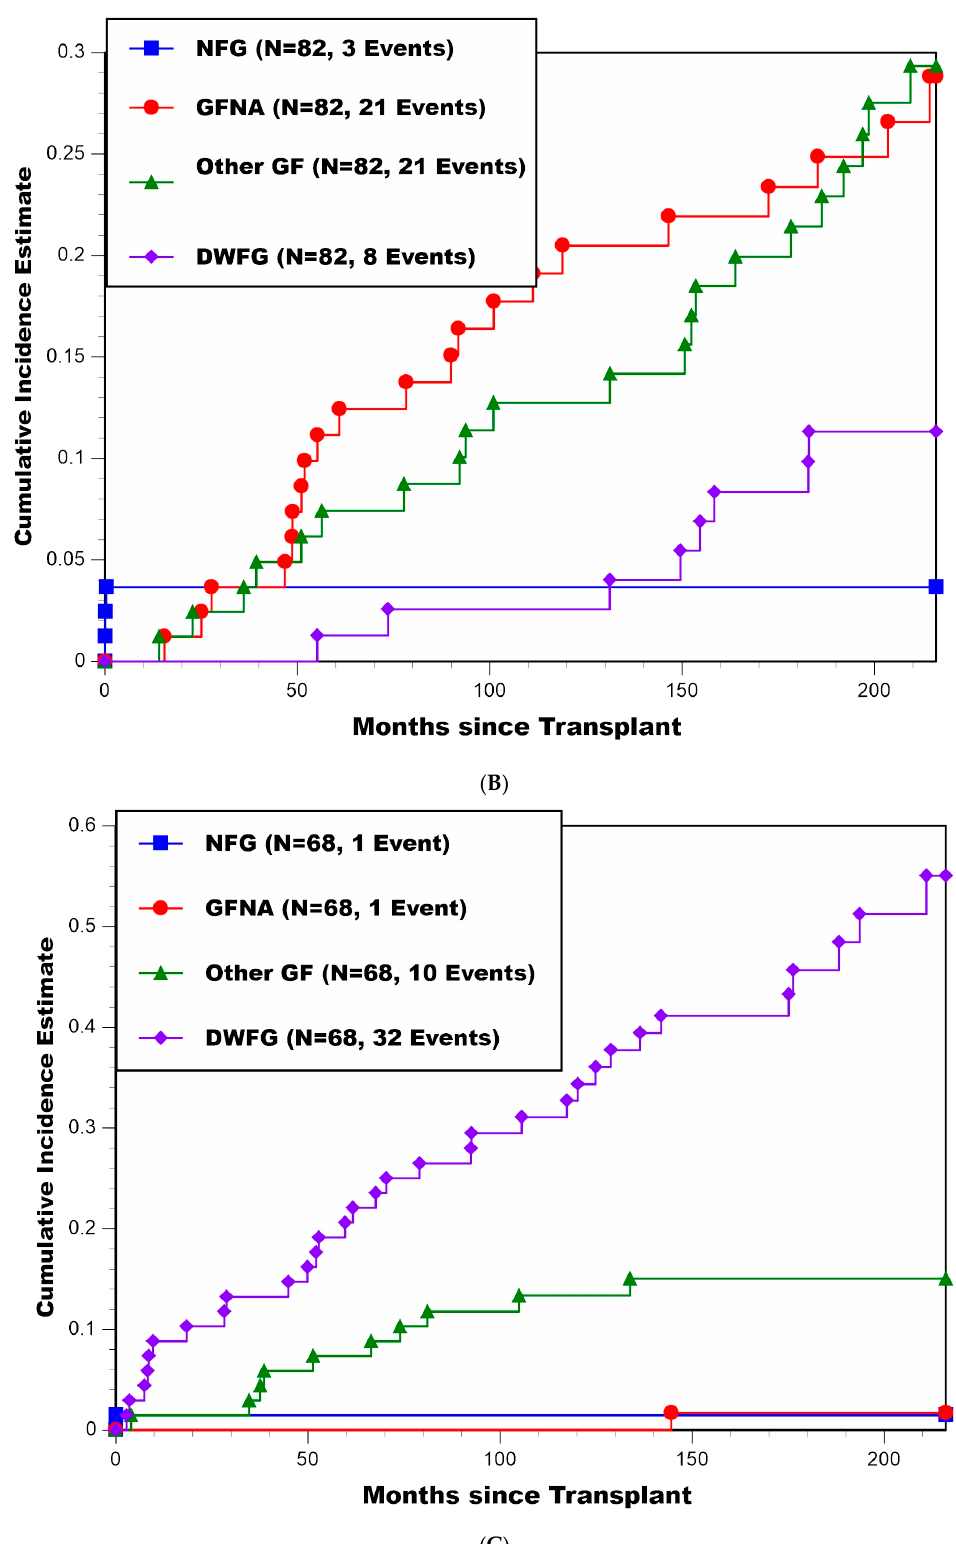
Figure 2. ( A ) Cumulative incidence estimates of four distinct causes of graft loss (NFG, GFNA, Other GF, and DWFG) for all patients combined; ( B ) cumulative incidence estimates of four distinct causes of graft loss (NFG, GFNA, Other GF, and DWFG) for patients <50 years of age at transplant; ( C ) cumulative incidence estimates of four distinct causes of graft loss (NFG, GFNA, Other GF, and DWFG) for patients ≥ 50 years of age at